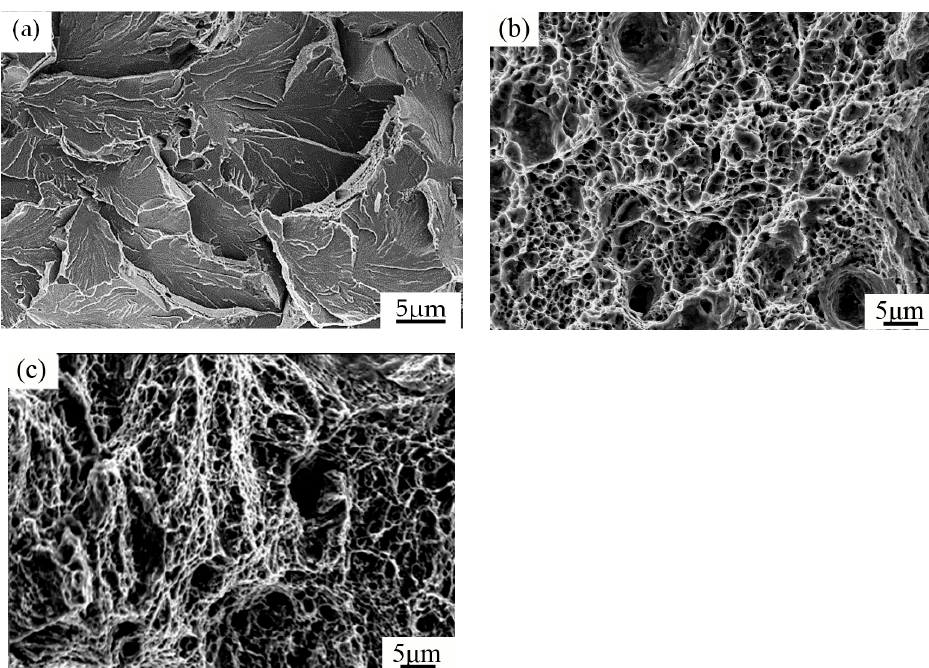
Figure 6. SEM micrographs of impact fracture surfaces of different casing drilling steels ( a ) Trans- granular cleavage facets on the fracture surface of K55 specimen; ( b ) a ductile fracture mode on the fracture surface of N80 specimen; ( c ) a ductile fracture mode on the fracture surface of P110 speci- men.